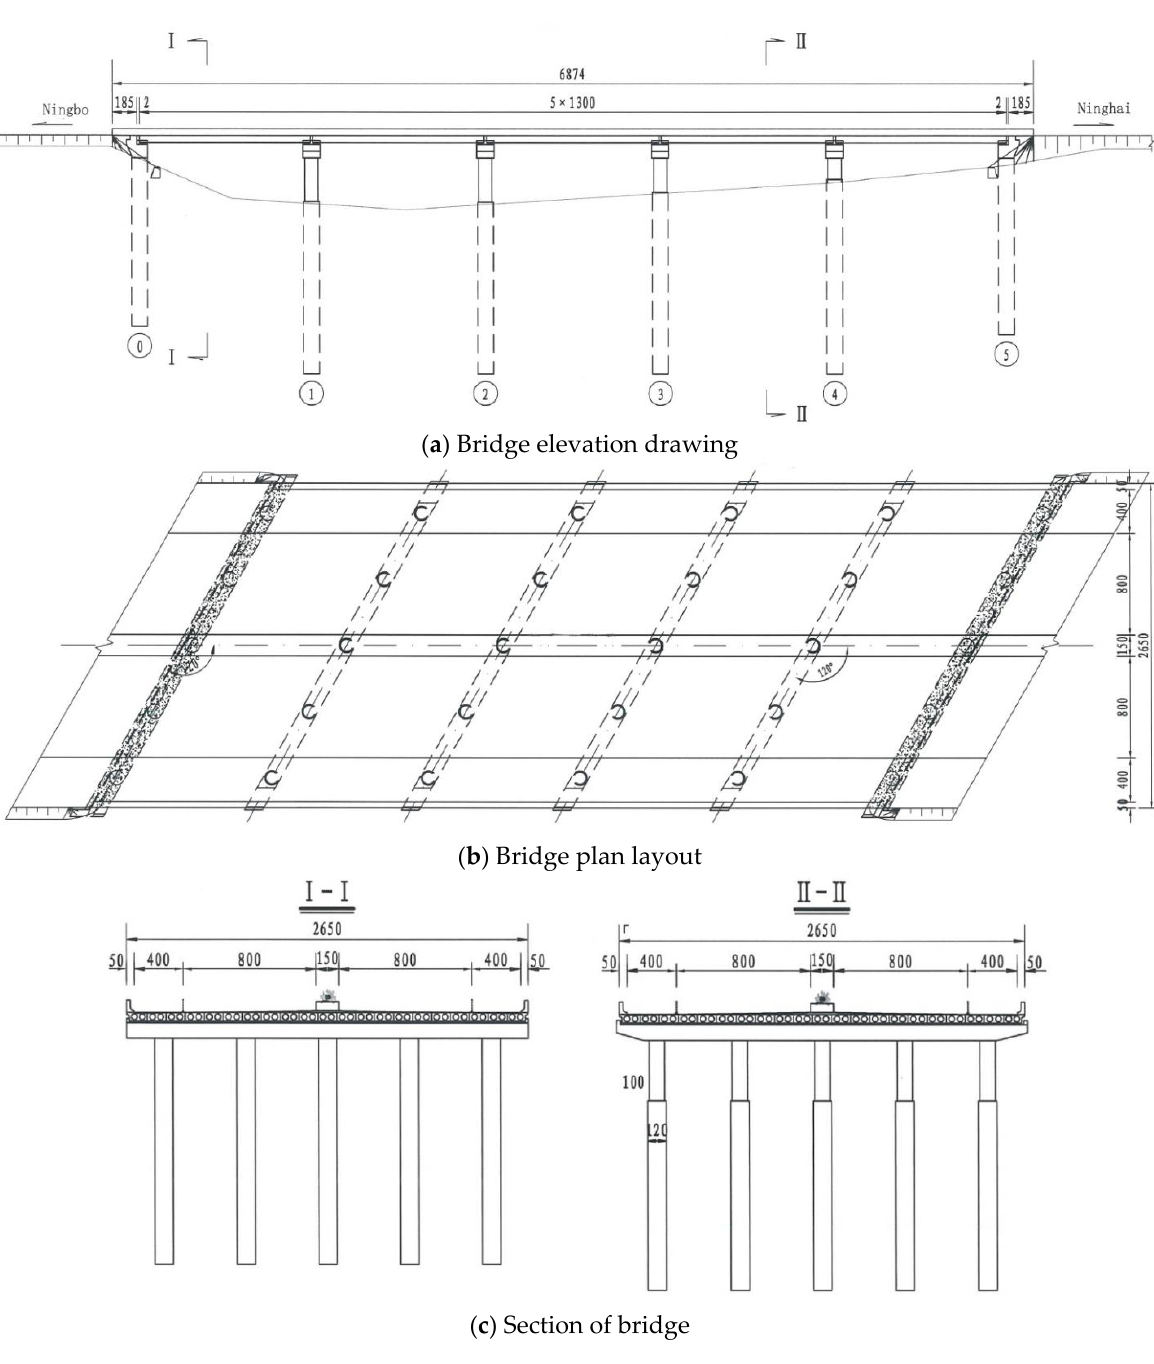
Figure 1. The bridge layout (unit: cm).